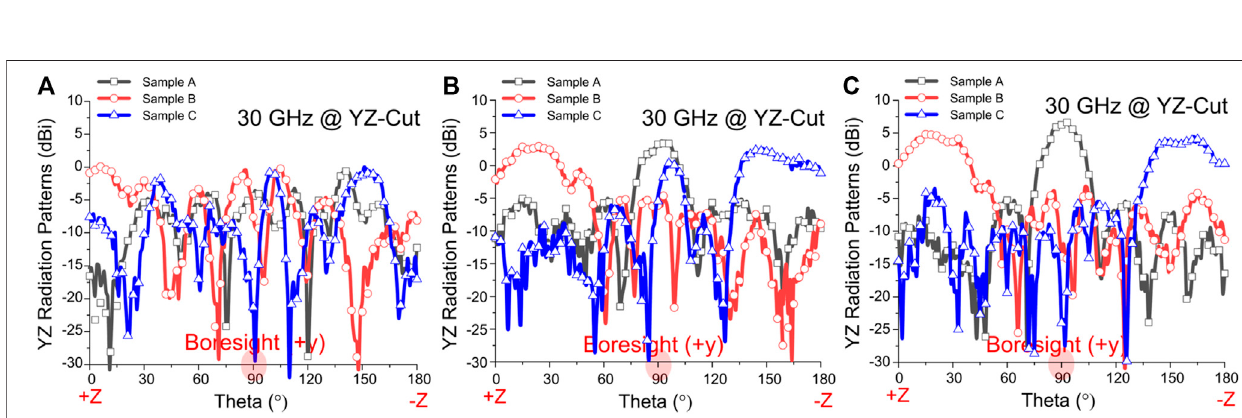
FIGURE7| Measuredradiationpatterns( E theta -polarization and26 GHz)ofthefabricatedarraysforthebeamsteeringtestinthehandsetmockup. (A) CPWTL. (B) GCPW TL without via fences. (C) GCPW TL with via fences.